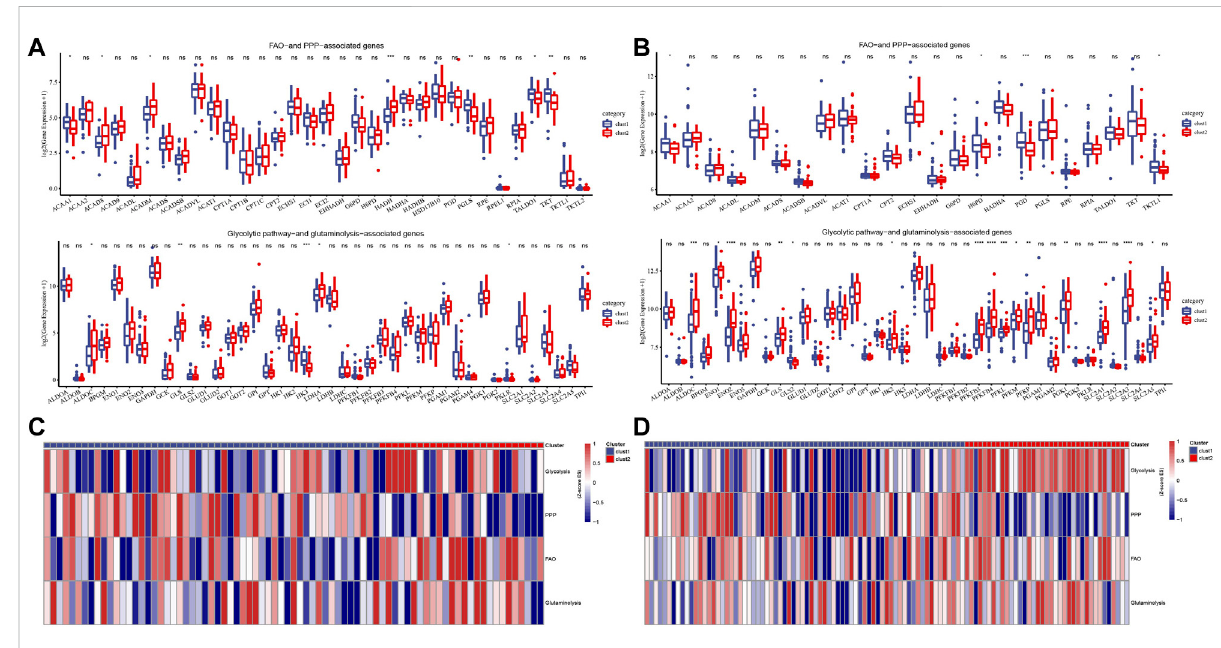
FIGURE 3 Potential metabolic patterns of two subtypes. (A) : The expression levels of genes in the four selected metabolic pathways between the two subtypes of the Target dataset. (B) : The differential expression analysis of four metabolism-related genes between cluster1 and cluster2 in the combined GSE dataset. (C) : The heat map shows the scores of different clusters of the Target dataset in the four metabolic pathways. (D) : Heat map ofscore trendsof thetwo subtypes infour metabolic pathways in thecombined GSE dataset. For this fi gure, theasterisks idicated the